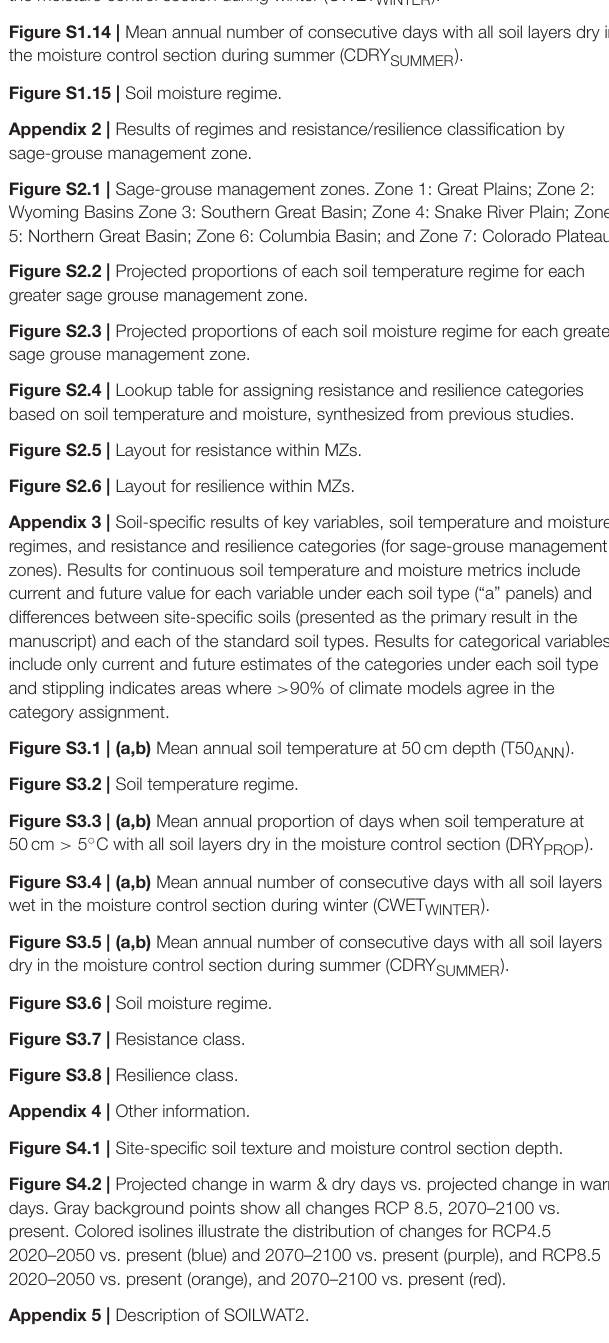
Figure S1.9 | Mean annual proportion of days when soil temperature at 50cm > 5 ◦ C with all soil layers dry in the moisture control section (DRY PROP ). Figure S1.10 | Mean annual maximum consecutive days with wet soil when soil temperature at 50cm > 8 ◦ C (CWET 8 ). Figure S1.11 | Mean annual number of days with all soil layers dry in the moisture control section (DRY ALL ). Figure S1.12 | Mean annual number of days with any soil layer dry in the moisture control section (DRY ANY ). Figure S1.13 | Mean annual number of consecutive days with all soil layers wet in the moisture control section during winter (CWET WINTER ). Figure S1.14 | Mean annual number of consecutive days with all soil layers dry in the moisture control section during summer (CDRY SUMMER ). Figure S1.15 | Soil moisture regime.